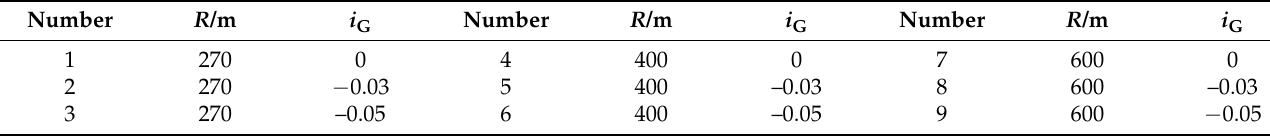
Table 3. Road geometric